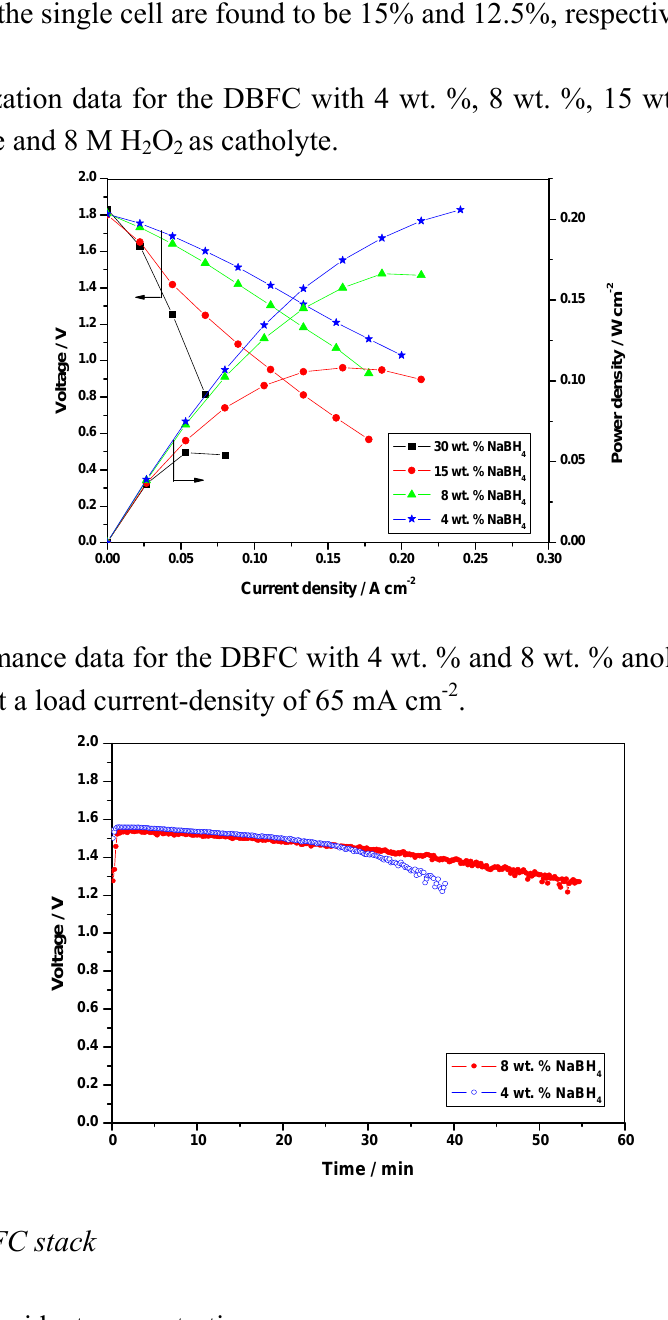
O as catholyte. 2 2